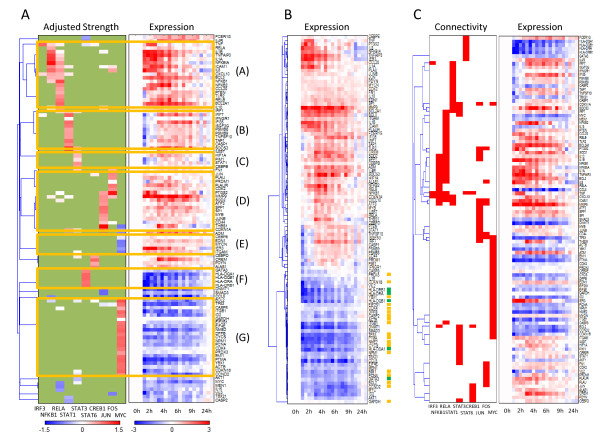
Hierarchical clustering in the context of a defined regulatory network. (A) The adjusted strength matrix was used for clustering, after which the gene expression matrix was appended. Seven major clusters which have more than five associated genes are highlighted. In the adjusted strength matrix heatmap, green color indicates that there is no prior regulatory connection in our model while white color indicates a weak regulatory influence. (B) Clustering with gene expression only. Genes in the Cluster F(regulated by STAT6) were noted with green dots, and genes in the Cluster G(regulated by MYC) were noted with orange dots. (C) Clustering with the binary regulatory relations (initial connectivity matrix) assuming all regulatory strengths are equal.